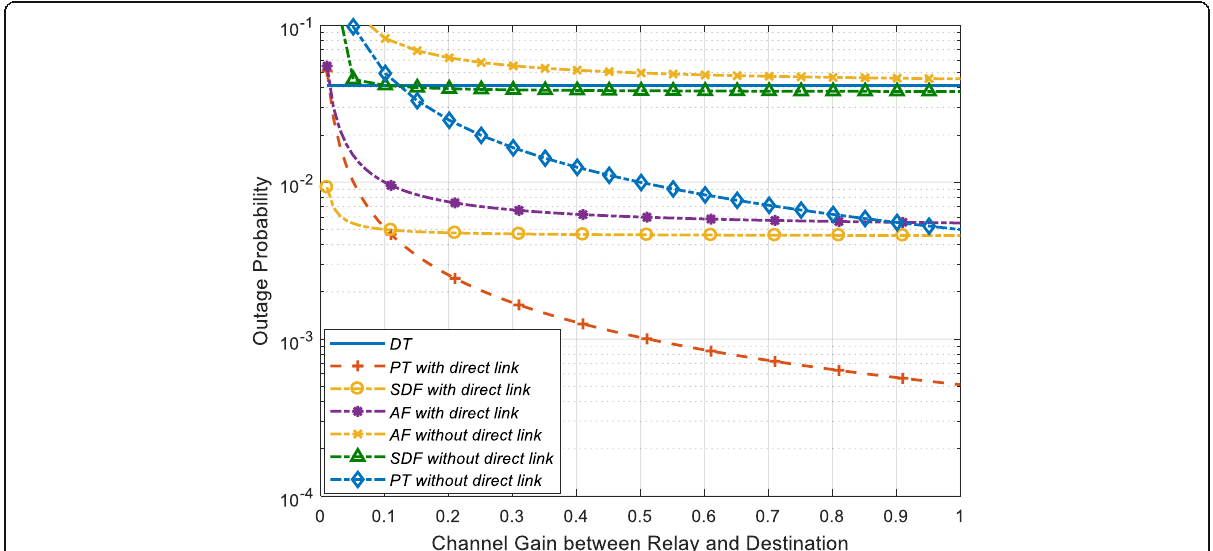
Fig. 7 Outage probability versus channel gain between relay and destination with one relay. Shows that the simulations on outage probability versus channel gain between relay and destination (R-D) of partial transmission (PT) and three conventional cooperative strategies, direction transmission (DT), selective decode-and-forward (SDF), and amplify-and-decode (AF), on the situations with one-relaying system. To simulate the unreliable relays, the simulation parameters are set as: the number of information bits is 100,000; the transmit SNR of source is 20 dB; other channel states from relays to destination (R-D) and source to destination (S-D) are set the same, as 0.1. The figure shows that PT gets the better performance than the conventional strategies as the R-D channel gain gets better than 0.1. It is also shown that SDF and AF are not able to obtain the spatial diversity gain from the R-D channel, because they are limited by the poor channel ahead of the relay. For SDF, the state of the S-D channel determines the decoding ability of the relay. For PT, although R node fails to decode all the information correctly, the benefit of R-D channel still obtains diversity gain for the